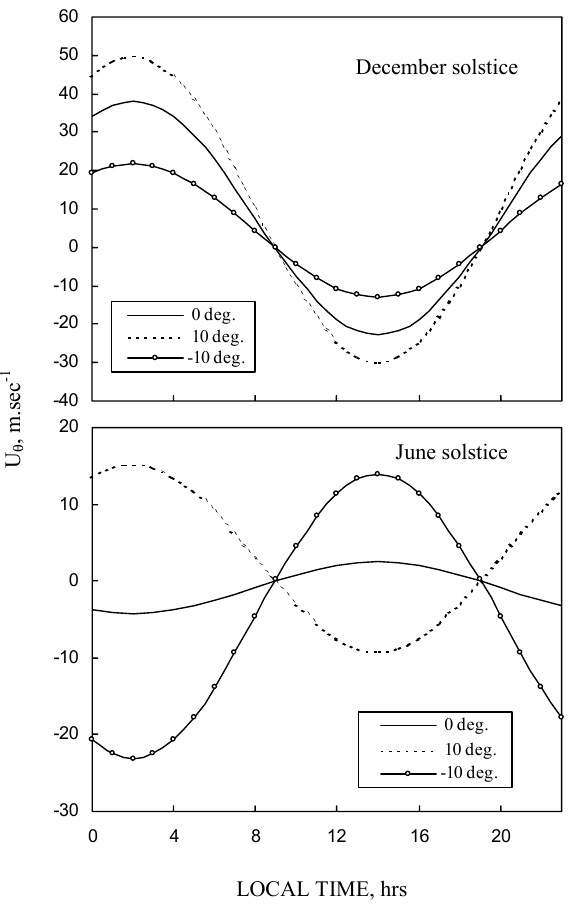
Fig. 1. Diurnal variation of neutral wind velocity for December (top) and June solstice (bottom) at three fixed geomagnetic lati-